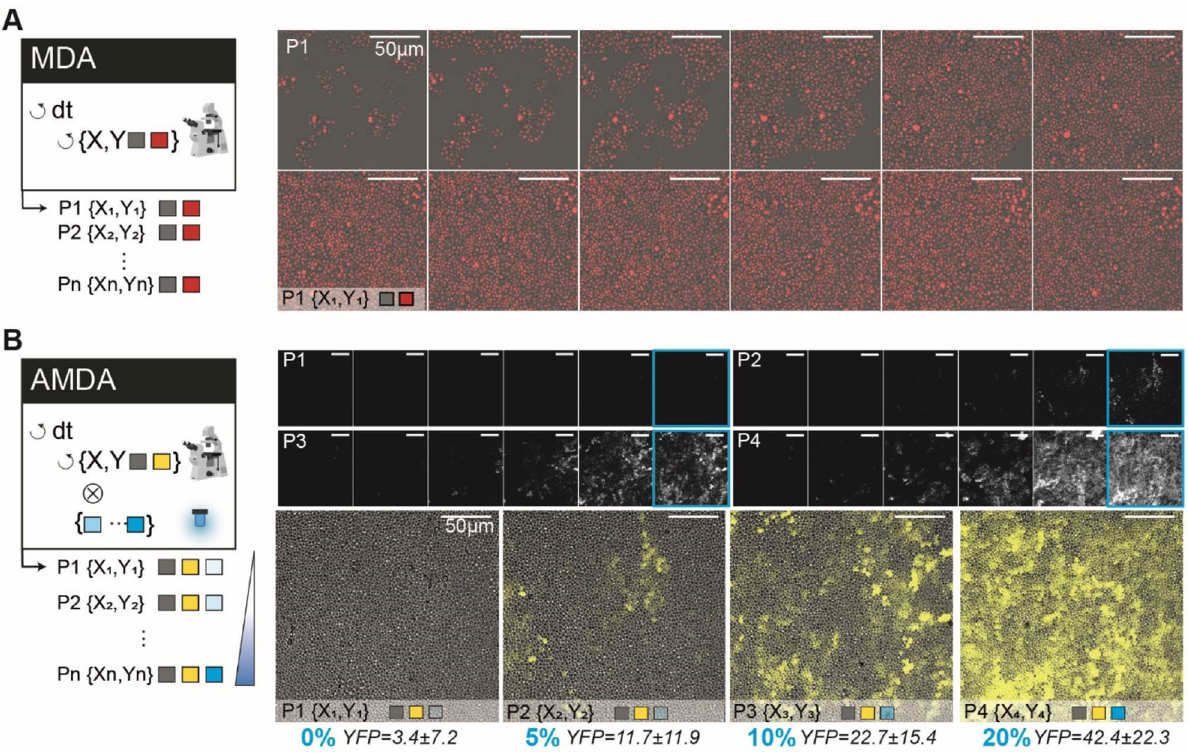
Figure 2. From simple to advanced MDA. ( A ) Example of a classic Multi-Dimensional Acquisition (MDA) protocol to observe yeast proliferation in a microfluidic chamber, with two imaging channels (brightfield and RFP) imaged every 6 min for several hours. The HTB2 protein of the yeast cells is tagged with a mCherry fluorescent reporter. A sketch of the program (nested loops) is shown on the left side: the imaging parameters are identical for every position and timepoint. ( B ) An advanced MDA, in which the user has defined several positions, but set different illumination settings in the blue channel (LED intensity: 0%, 5%, 10% and 20%). This programming was done without scripts, by just using the drag and drop interface (see Supplementary Materials). Yeast cells bearing an optogenetic gene expression system (pC120-venus) were imaged for 15 h. Each position is exposed to a different level of light stimulation, which alters the expression of a yellow fluorescent reporter both in terms of cell–cell variability, the maximum level of expression and dynamics. Thus, in one experiment, it was possible to quantitatively calibrate the pC120 optogenetic promoter using our settings without any requirement for coding (objective × 20). Fluorescence levels are averaged across the field of view and the error values are the standard deviation of pixel